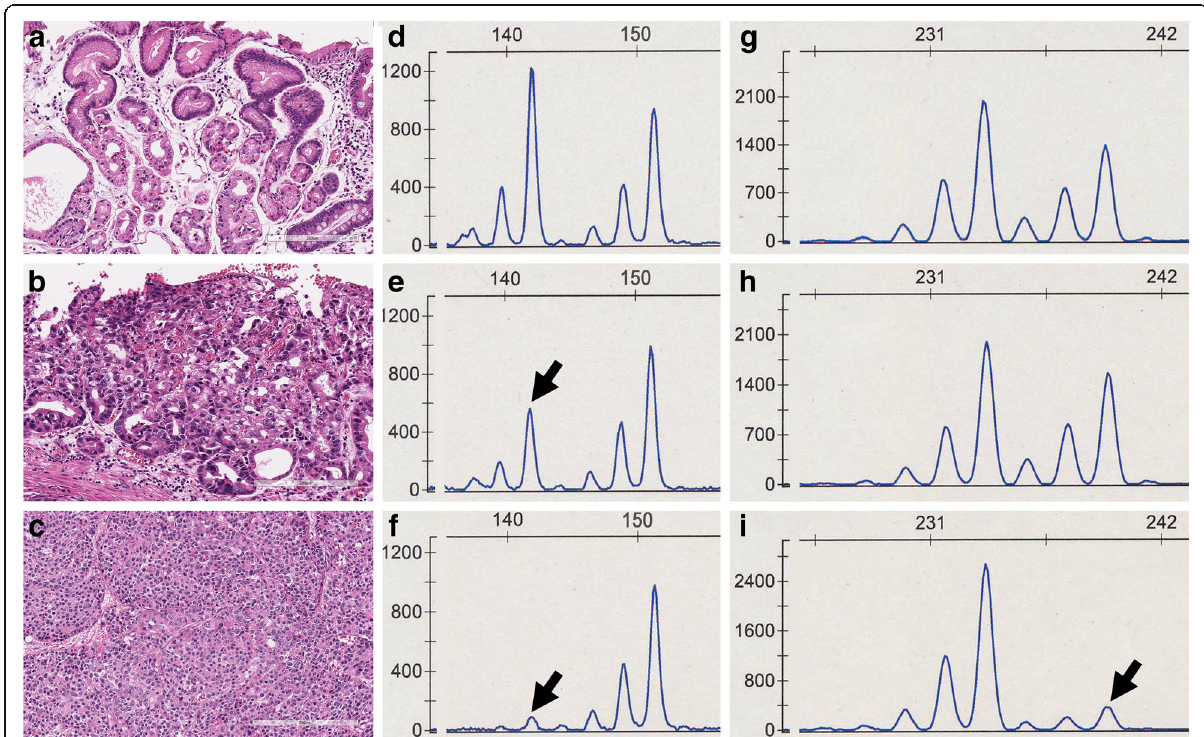
Fig. 3 Representative results of allelic imbalance analysis. a - c Consecutive hematoxylin and eosin (H&E)-stained specimen of the tissue sampled for DNA extraction. a Non-neoplastic mucosa sampled for d and g , b Glandular tumor component sampled for e and h , and c Acinar-endocrine component sampled for f and i . d - f The alleles at D8S532. e and f show loss of heterozygosity (LOH) (black arrows). g - i The alleles at D11S5014. h showed heterozygosity, but i showed LOH (black